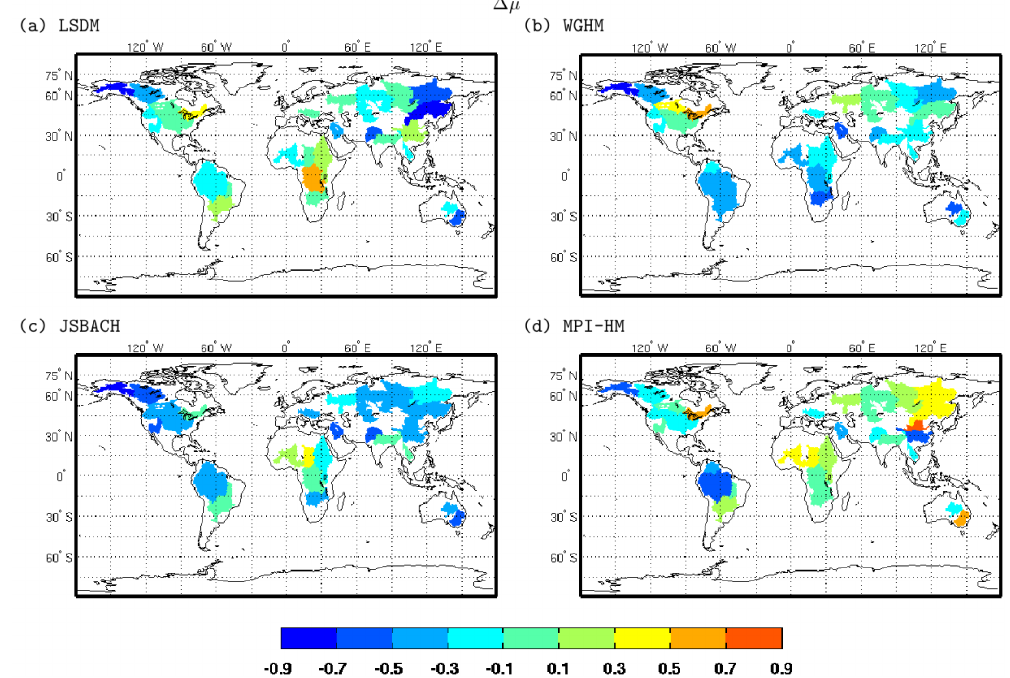
Figure 2. Relative amplitude differences of four hydrological model realizations with GRACE-based TWS observations.